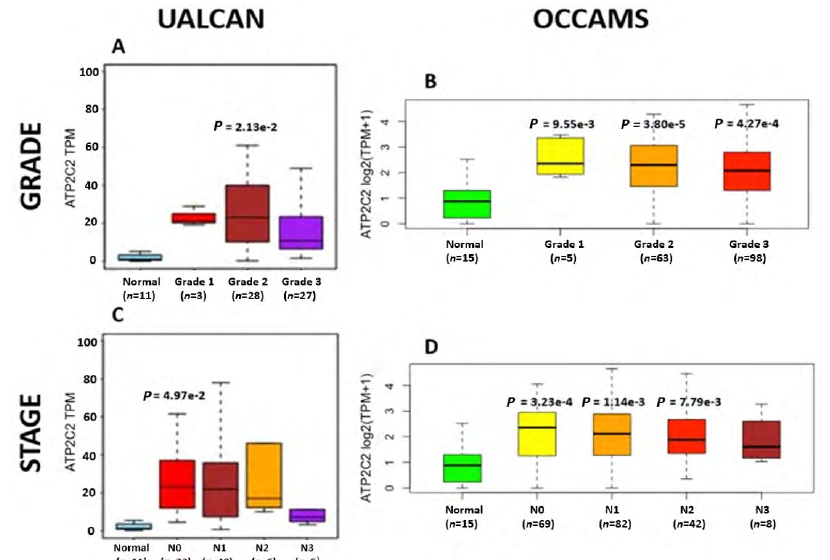
Figure 14. OAC tumor grade and nodal metastatic stage boxplots for ATP2C2 . Details as described in Figure